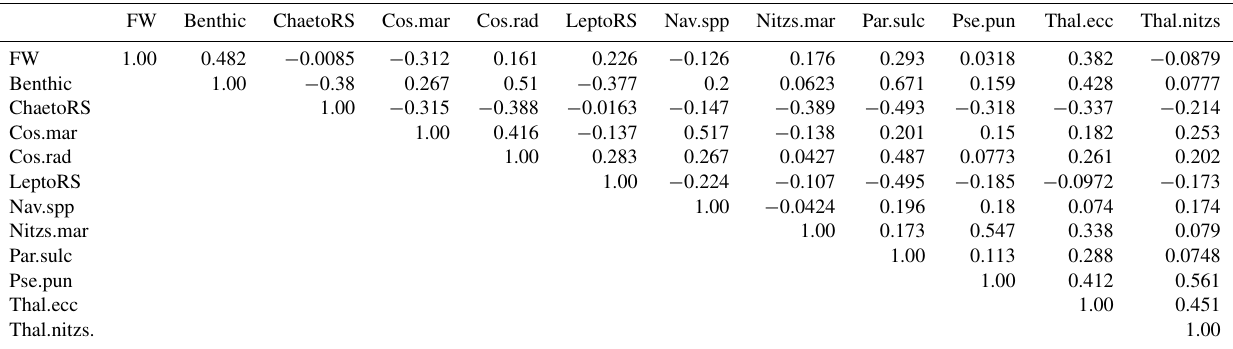
Table 2. Pearson correlation matrix for the sediment trap diatom species relative abundances (%). FW: freshwater diatoms; ChaetoRS: Chaetoceros spp. resting spores; Cos.mar: Coscinodiscus marginatus ; Cos.rad: Coscinodiscus radiatus ; LeptoRS: Leptocylindrus spp. resting spores; Nav: Navicula ; Nitzs.mar: Nitzschia marina ; Par.sulc: Paralia sulcata ; Pse.Pun: Pseudo-nitzschia pungens ; Thal.ecc: Thalassiosira eccentrica ; Thal.nitzs: Thalassionema nitzschioides .